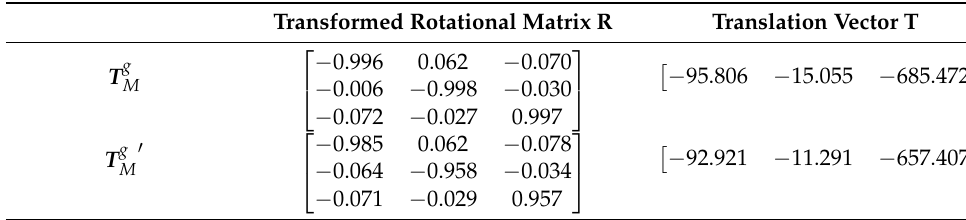
Table 7. Transformation from mold model to scanning galvanometer.